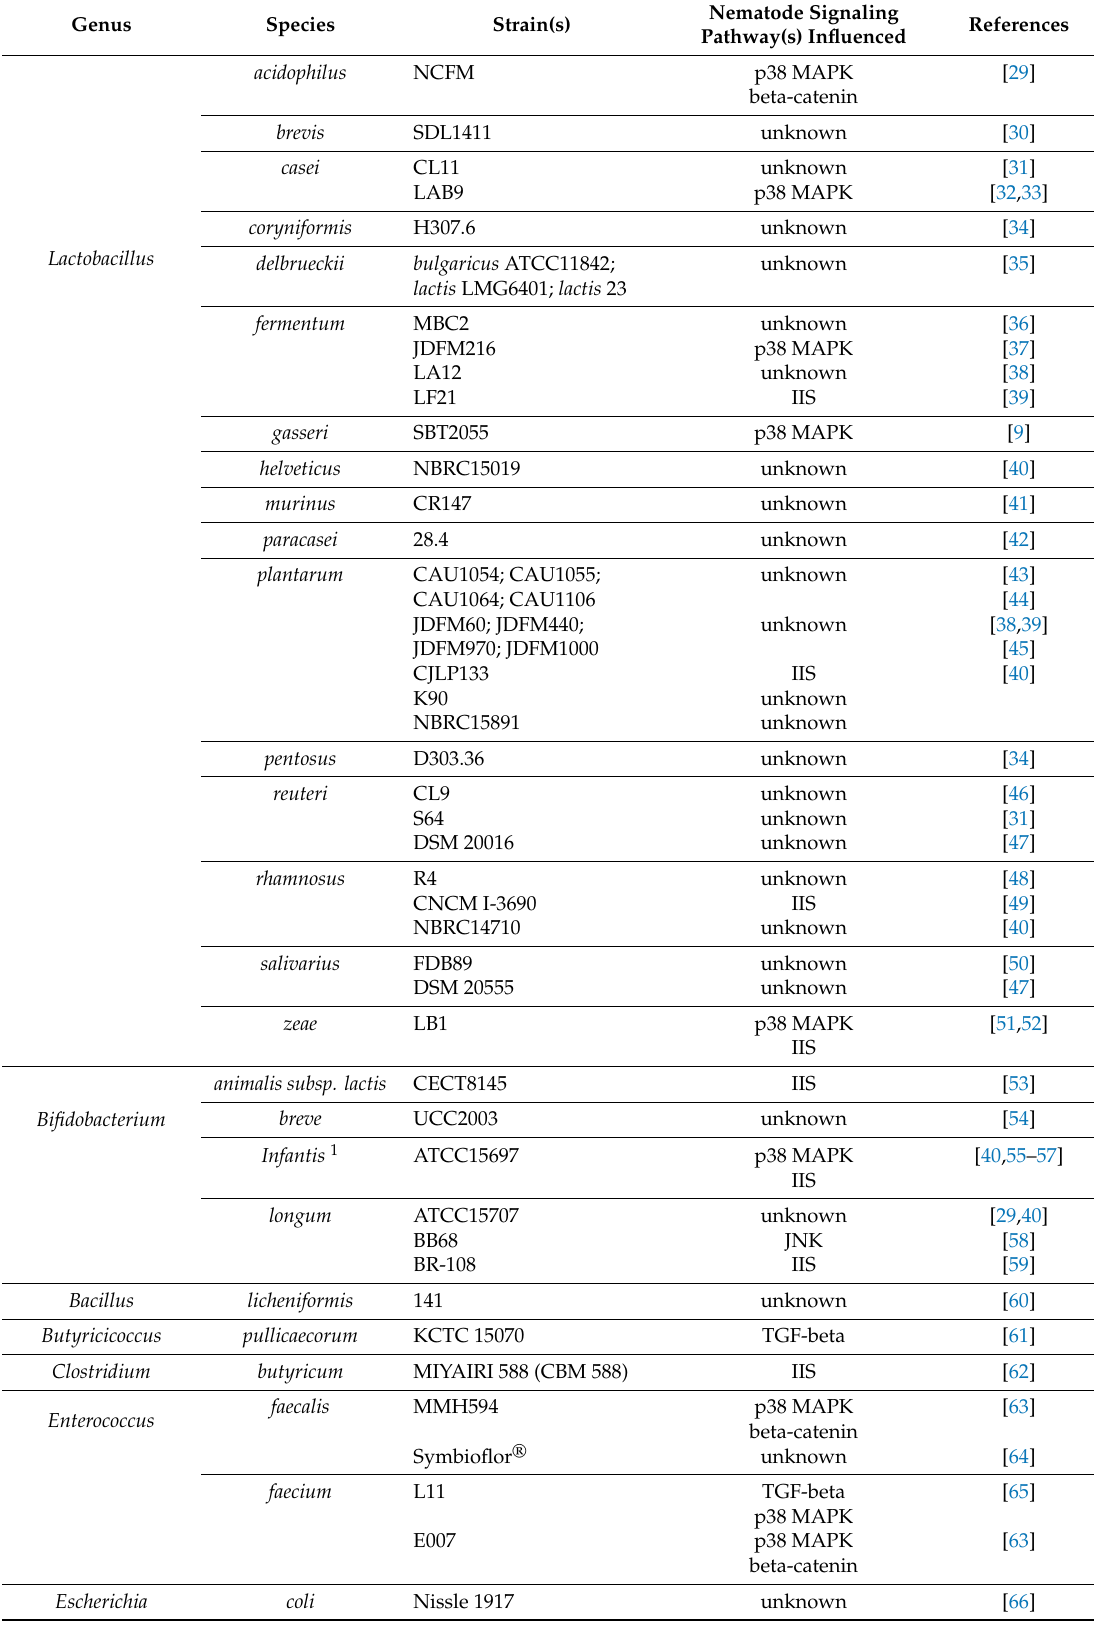
Table 1. List of microbial strains reported in the selected literature to exert a probiotic activity in C. elegans